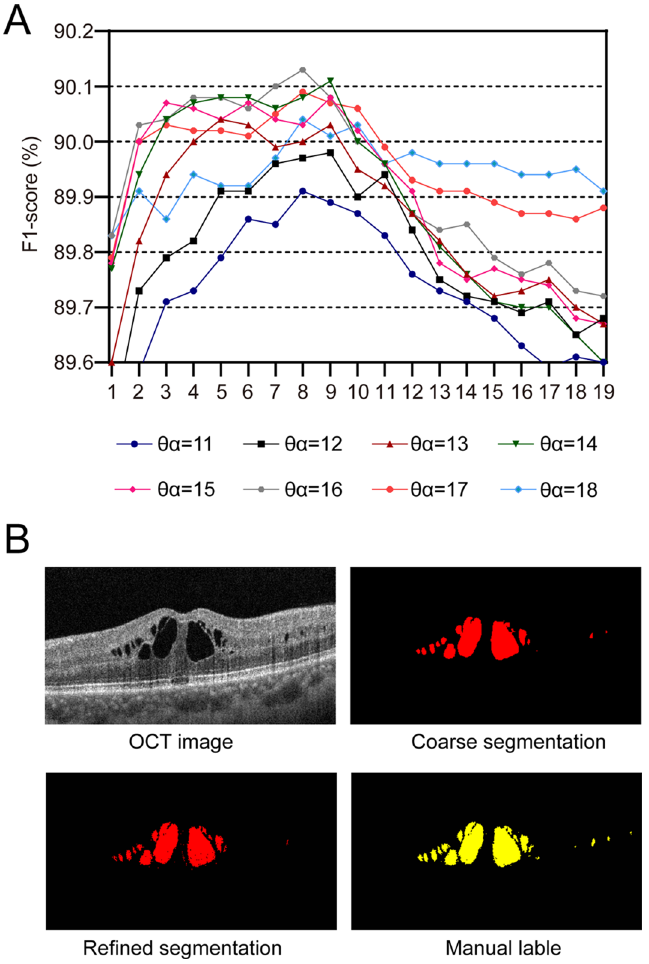
Figure 6. Refine the segmentation results of macular edema by FC-CRF. ( A ) Sensitivity test for FC-CRF model. ( B ) Refined segmentation result of macular edema in OCT